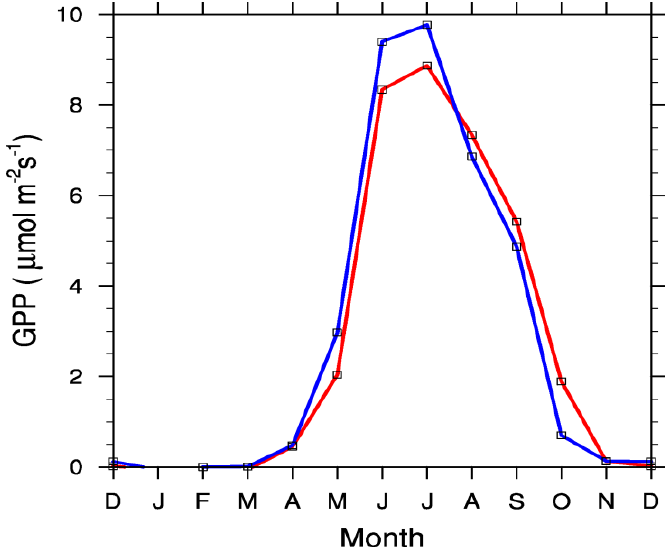
Figure 3. The annual cycle of monthly mean gross primary production (GPP) from Bartlett Experimental Forest flux tower observations for the year 2005 and